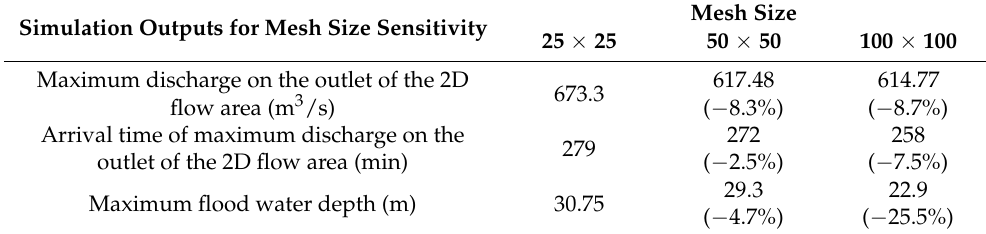
Table 7. Mesh size sensitivity analysis